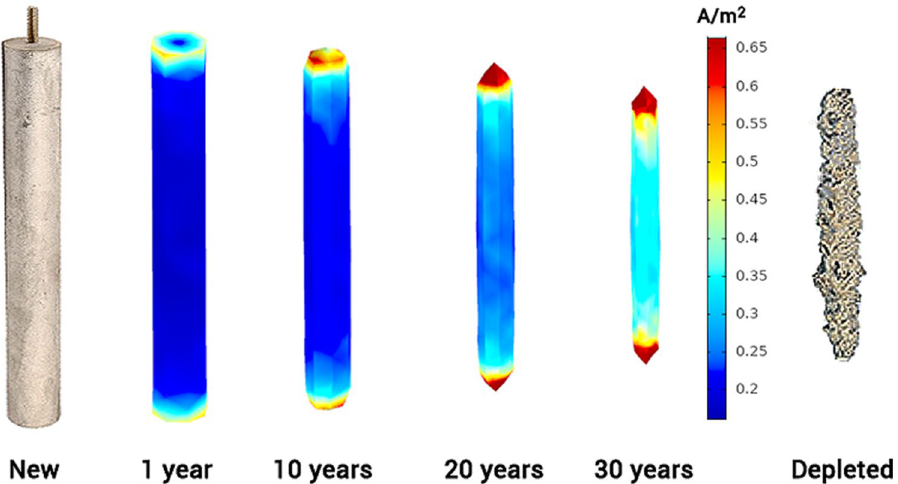
Figure 3. Current density (A/m 2 ) distribution and anode depletion pattern during in-service life of 30 years, with a soil resistivity of 4000